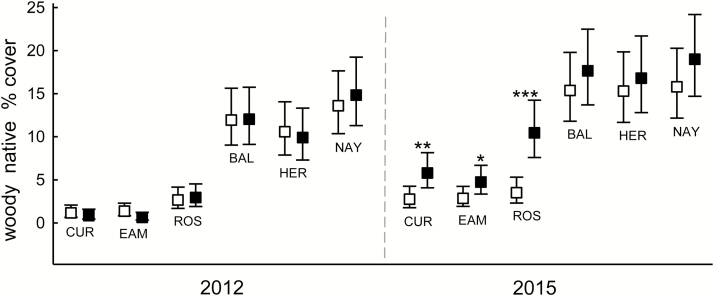
Fall cover (%) of woody native species in the herb layer within six suburban forests in central New Jersey, in fenced plots (filled symbols) or in plots with deer access (open symbols). Data are combined across the Microstegium vimineum seed addition and no-addition plots, and are means ± 95 % CI (back-transformed from logits) of 16–20 plots. Asterisks above the mean indicate significant differences in a forest within a year (Tukey–Kramer adjusted: *P < 0.05, **P < 0.01, ***P < 0.001).